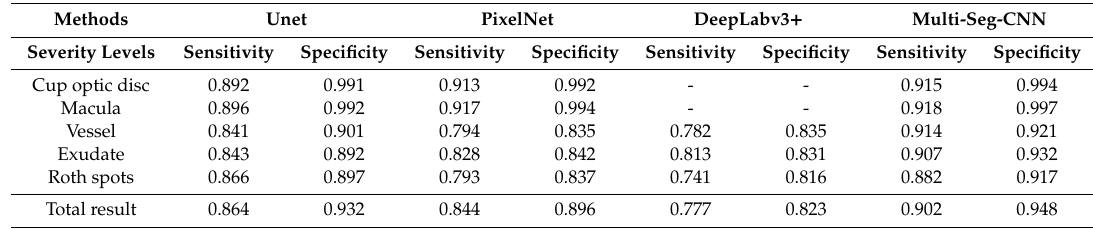
Table 6. Retinal image segmentation accuracy by di ff erent